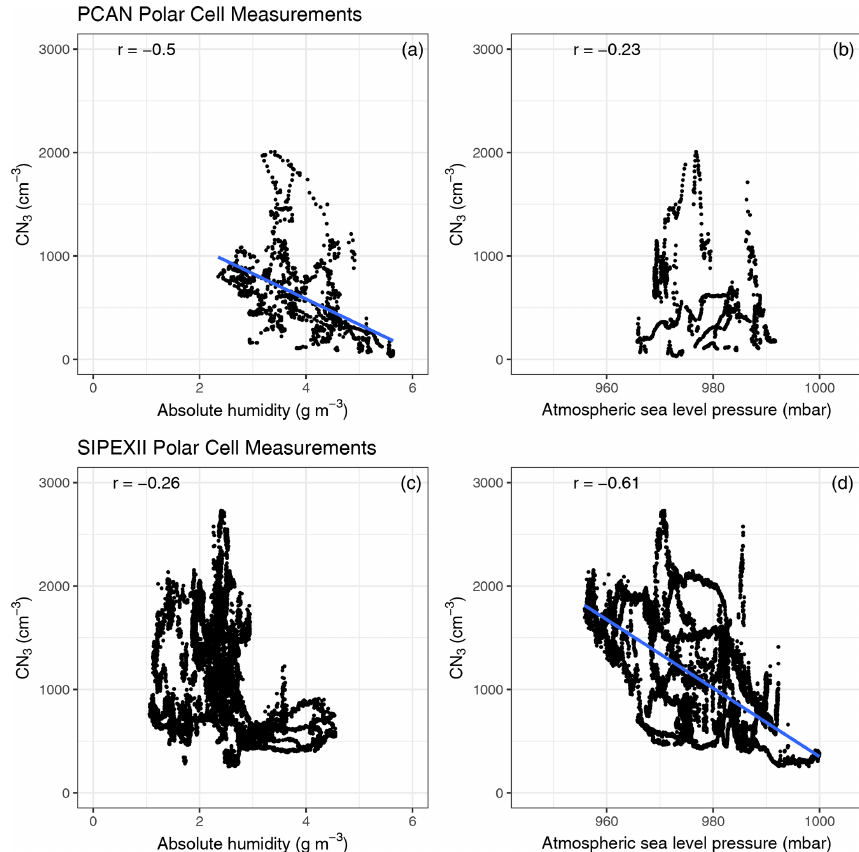
Figure 6. Comparison of PCAN (a, b) and SIPEXII (c, d) AH and atmospheric sea level pressure measurements plotted against CN 3 measurements in the polar cell. Linear regression lines are plotted on the stronger relationship for each voyage. Pearson’s r values are plotted in each